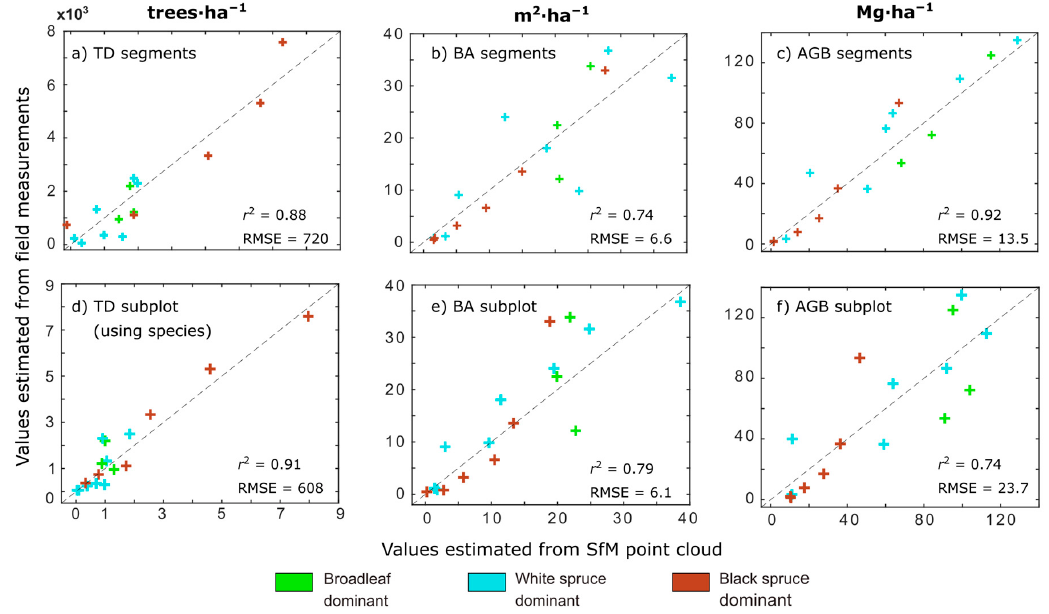
Figure 5. Subplot-aggregated estimates of forest structure. Top row ( a – c ) segment-level analysis followed by aggregation; Bottom row ( d – f ), modeling using full subplot point cloud (area-based, no